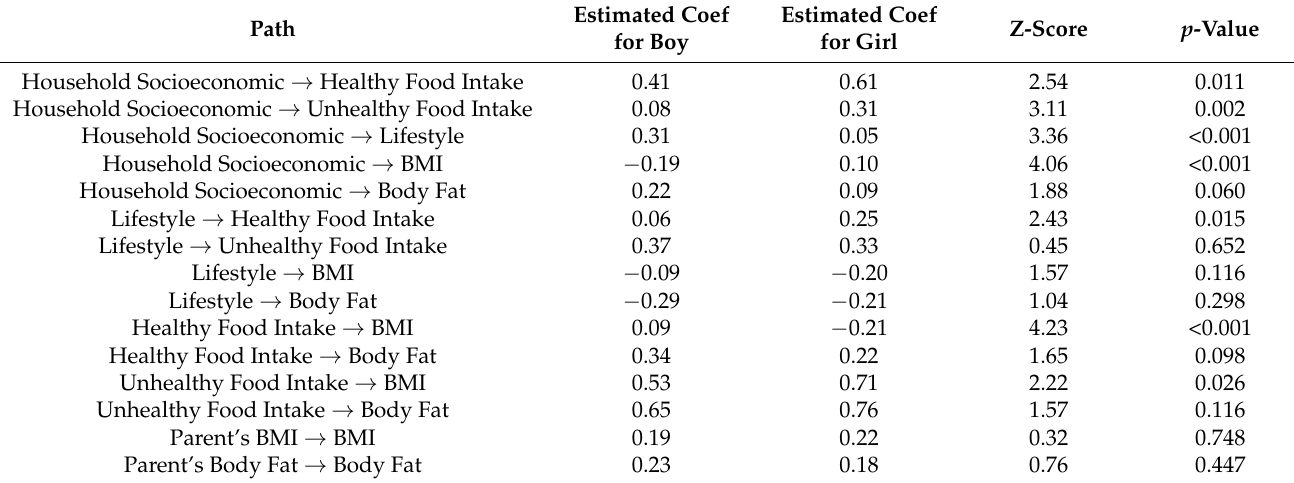
Table 6. Multi-group analysis between the adolescent boy and girl models. Estimated Coef Path for